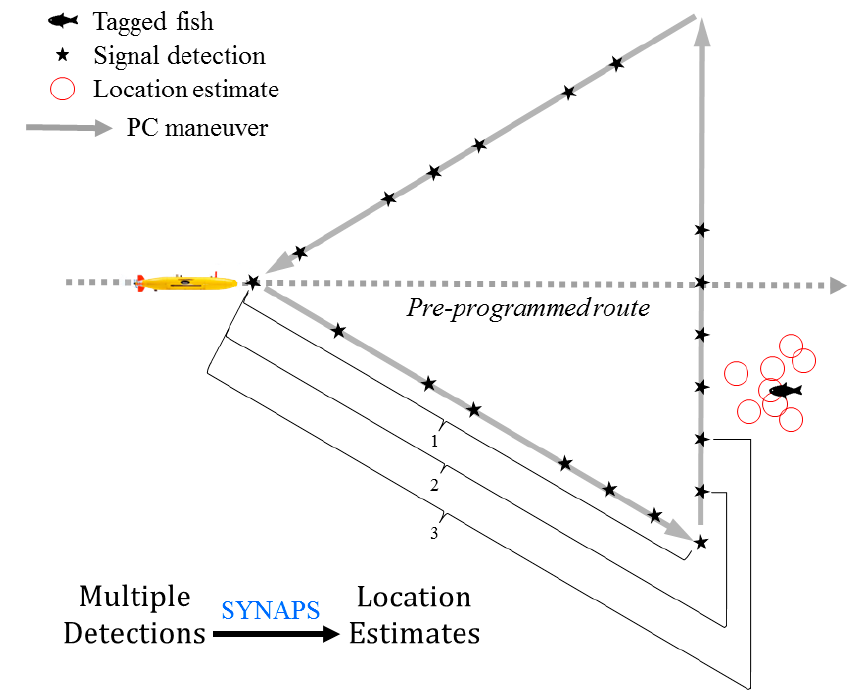
Figure 3. Payload control (PC) maneuver, consisting of a base-forward triangle, used by an autonomous underwater vehicle to estimate the location of acoustically tagged fish. SYNAPS software was used to calculate a series of location estimates using multiple signal detections, starting with the first 8 detections (Estimate 1) and increasing incrementally (Estimate 2 based on 9 detections, Estimate 3 based on 10 detections,